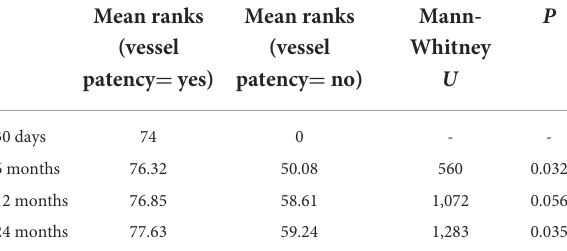
TABLE 8 Endovascular time mean ranks vs. target vessel patency in each period.